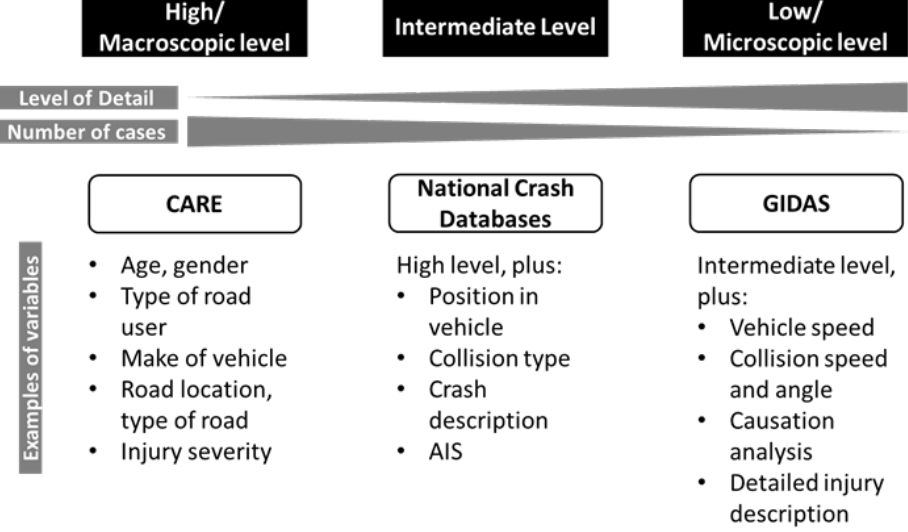
Figure 2. Overview of databases used for analysis.